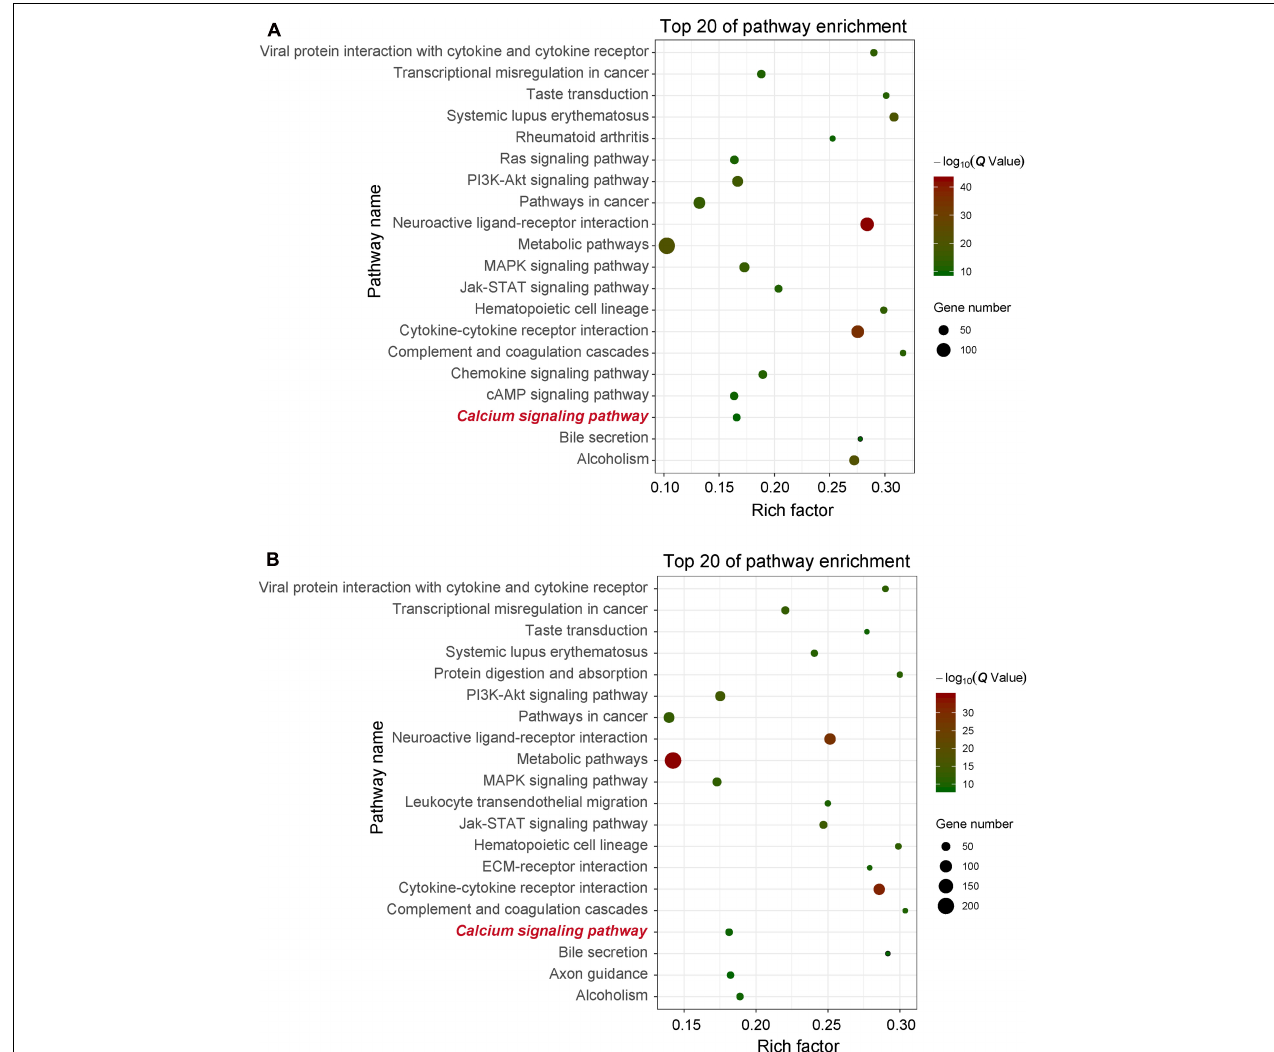
FIGURE 4 | KEGG enrichment of DEGs induced by VZV in SH-SY5Y cells. (A) The DEGs enriched KEGG pathway was induced by VZV infection in SH-SY5Y cells for 24 h. (B) The DEGs enriched KEGG pathway was induced by VZV infection in SH-SY5Y cells for 48 h. The graph shows the top 20 significantly enriched KEGG pathways by plotting rich factors as abscissa and KEGG terms as